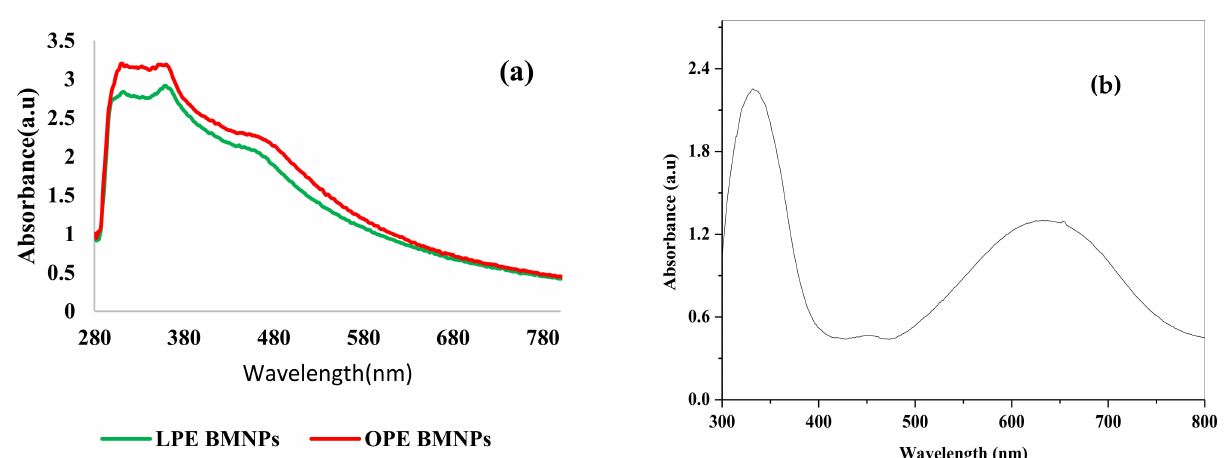
Figure 1. The UV-Vis of ( a ) Comparison of the synthesis for the two CPE/NPs ( b )